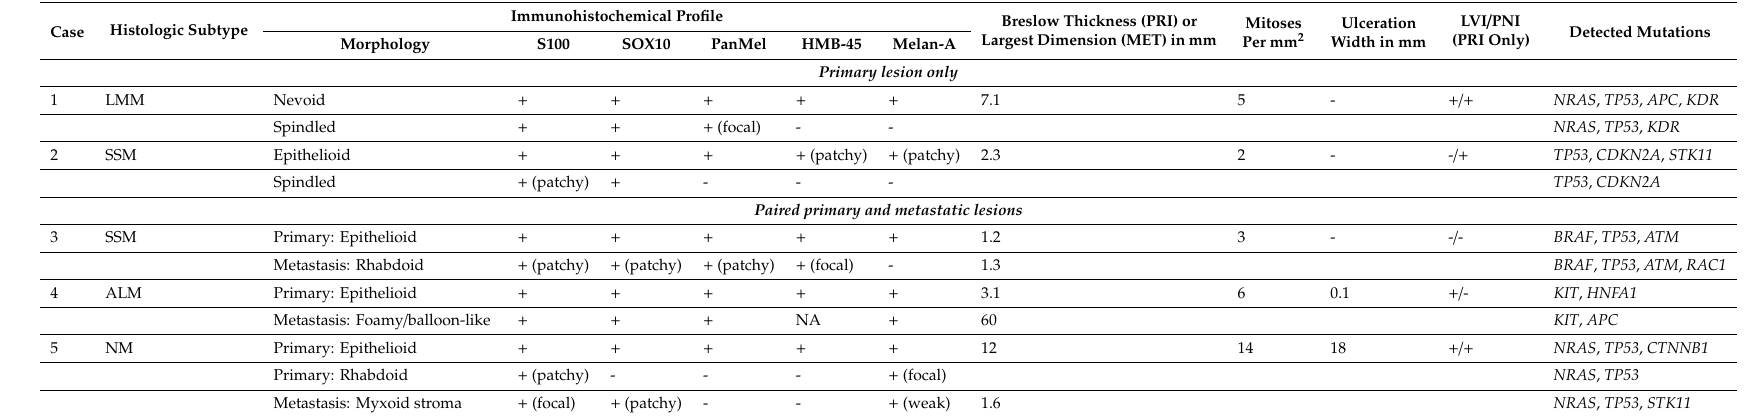
Table 2. Histopathologic, immunohistochemical, and molecular findings of the melanomas analyzed by next-generation sequencing. Abbreviations: PanMel, Pan-melanocytic cocktail; PRI, primary; MET, metastatic, LVI, lymphovascular invasion; PNI, perineural invasion; LMM, Lentigo maligna melanoma; SSM, superficial spreading melanoma; ALM, acral lentiginous melanoma; NM, nodular